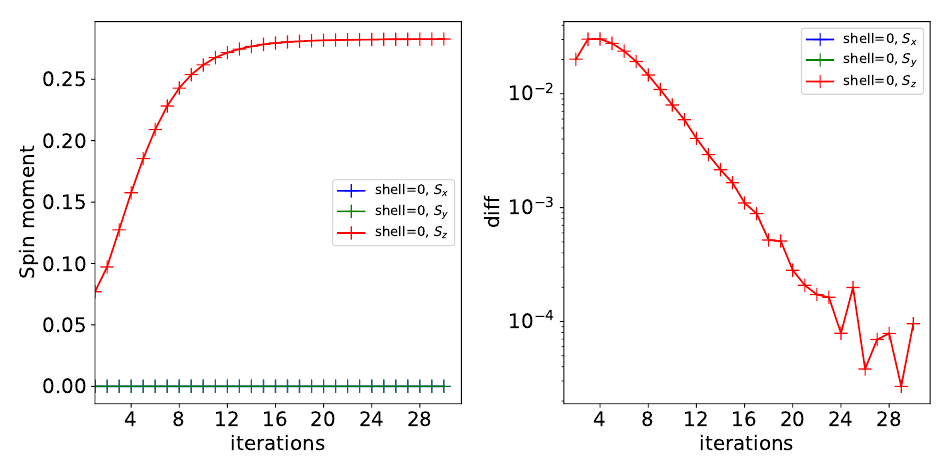
Figure 11: Spin moment m ξ ( s ) ( ξ = x , y , z ) for inequivalent site s = 0 as a function of the iteration number. The left panel shows m ξ ( s ) itself and the right panel shows the difference between iterations i and i −